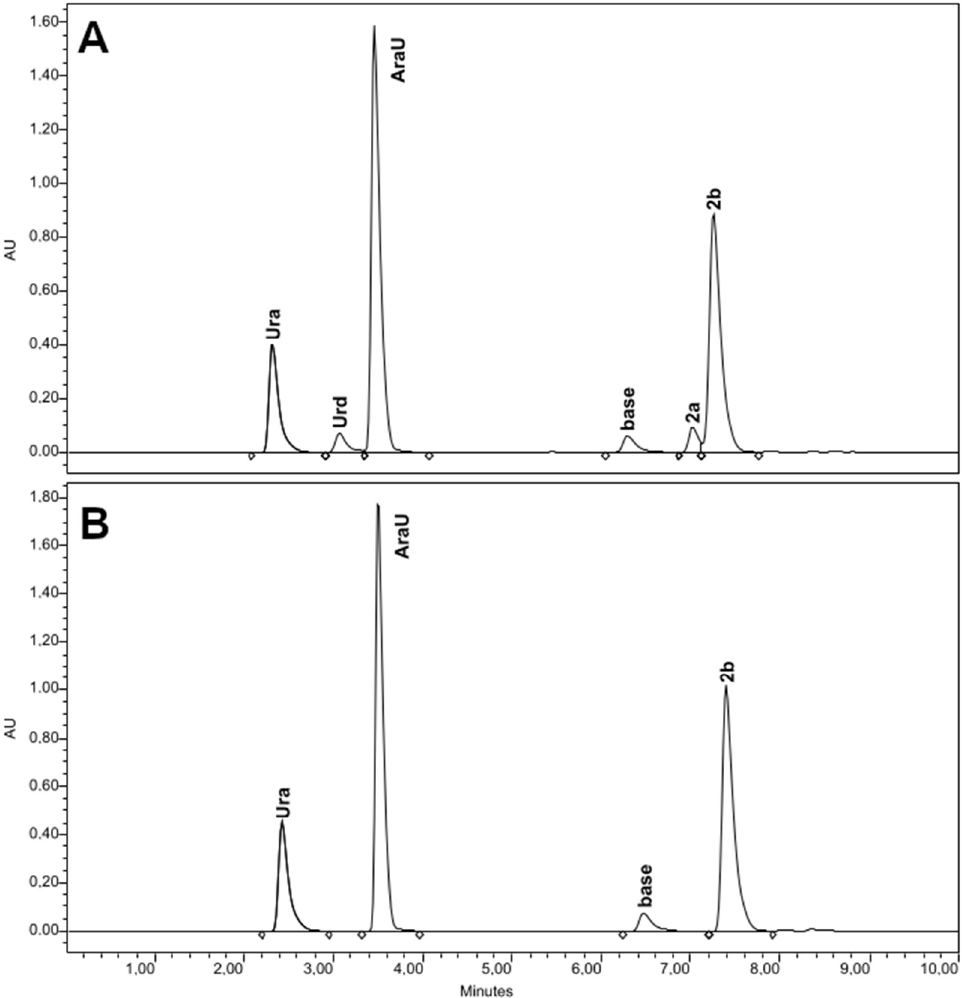
Figure 4. HPLC-profiles of the reaction mixture for the synthesis of an alanine derivative 2b without arsenate ( A ) and with sodium arsenate ( B ). Table 2. Retention time (RT) and peak area of compounds.